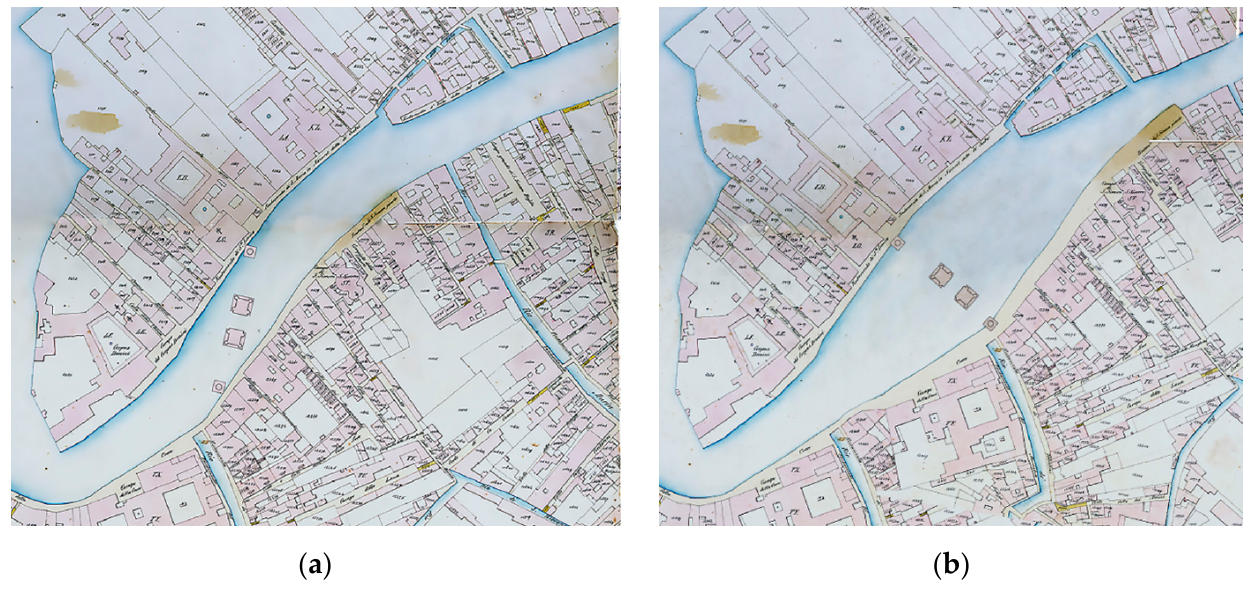
Figure 20. ( a ) The Triumphal Apparatus is positioned within the city, based on the references ob- tained from the inverse method of perspective; ( b ) The Triumphal Apparatus is positioned within the city shown by Borsato’s painting, based on the references obtained from the inverse method of perspective.